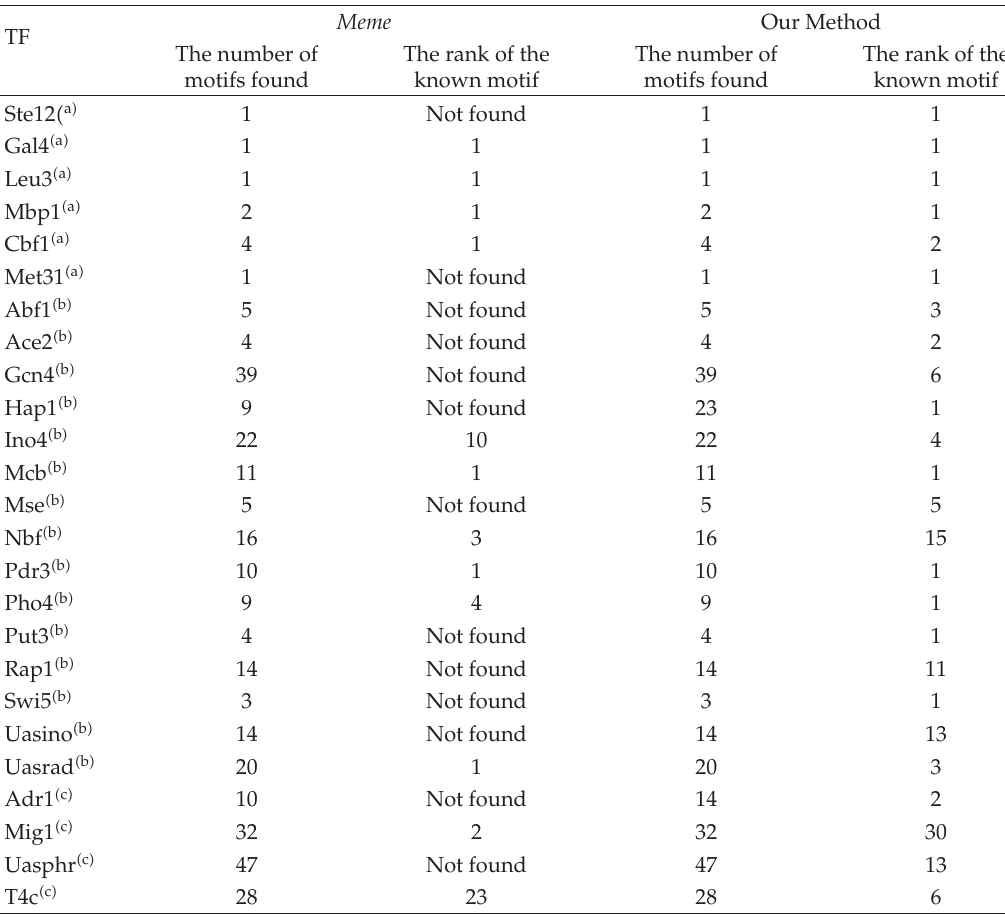
Table 4: Comparison to MEME . MEME requests a predetermined number of predicted motifs as its input, and we let it be the number of motifs predicted using our method. For each TF, we listed the rank of the known motif in the predictions. Three di ff erent parameter threshold settings, namely, (cid:2) a (cid:3) , (cid:2) b (cid:3) , and (cid:2) c (cid:3) , are used in our method as given in Table